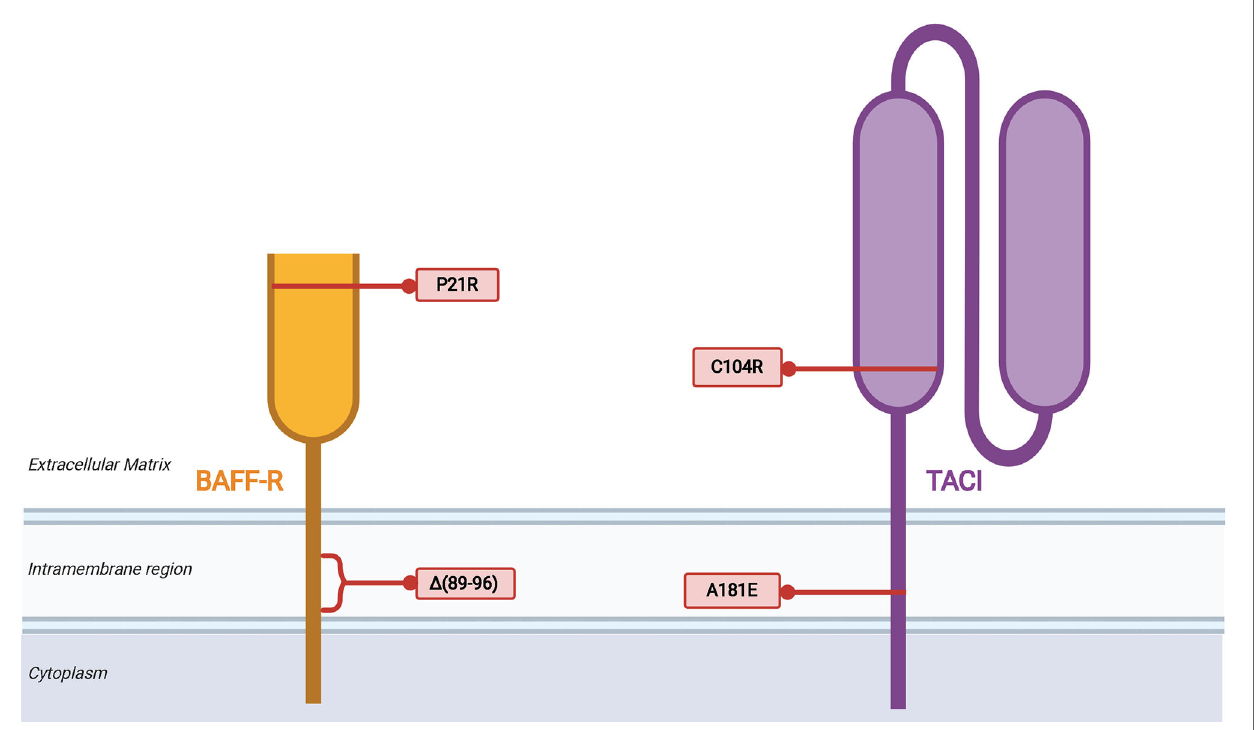
FIGURE 2 | Mutations of TNFRSF13B (TACI) associated with CVID. The variants listed are limited to the two most common, C104R and A181E, which are discussed in the text, as well as two other illustrative examples of how disruption of TACI can impair B cell function. Proposed mechanisms of biochemical disruption of certain variants